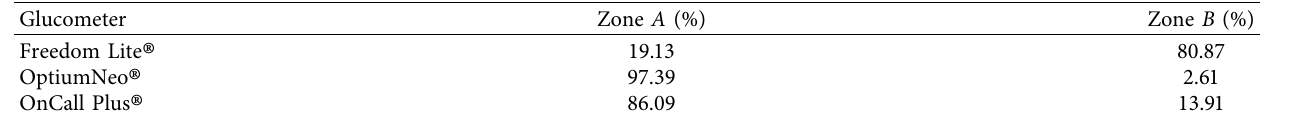
Table 6: Error grid analysis of measurements obtained using glucometers.